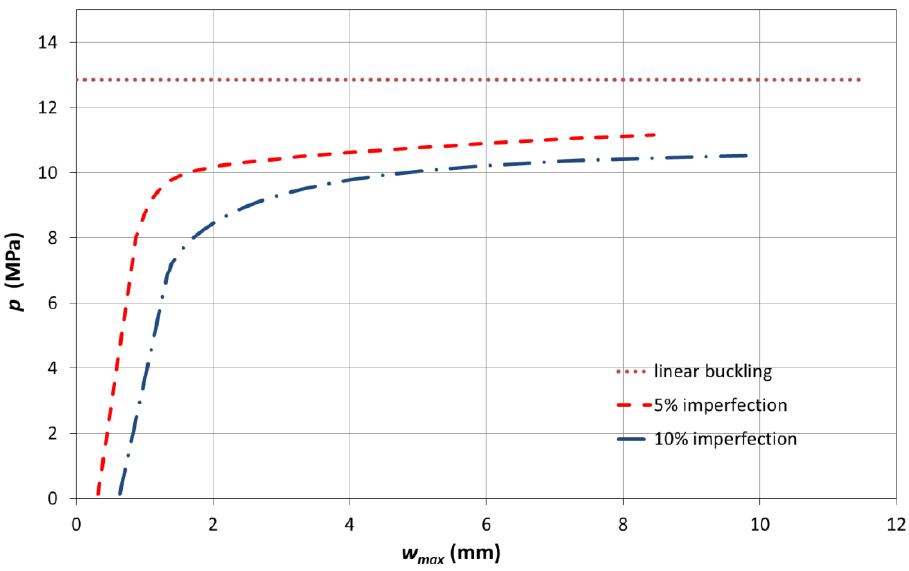
Figure 19. Critical buckling pressure for the perfect shell (linear bifurcation analysis) and geometrically nonlinear analysis curves for shells with imperfections.